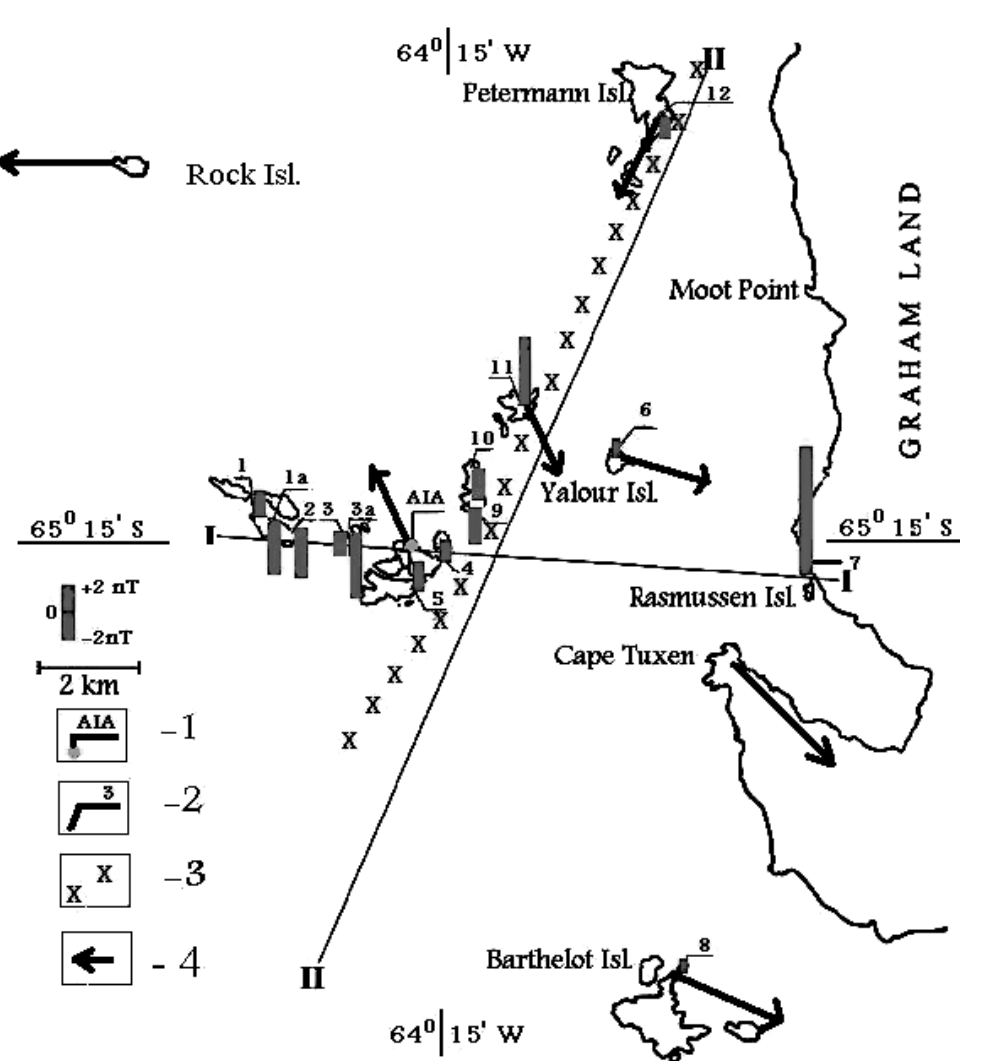
Fig. 1. Antarctic tectonomagnetic polygon and temporal variations of geomagnetic field ( ∆∆ F) in 2004 - 2005. 1 magnetic observatory AIA, 2 tectonomagnetic points, 3 prognoses fault line, 4 vectors of geodetic points dis- placements (Tretyak et al. , 2006)